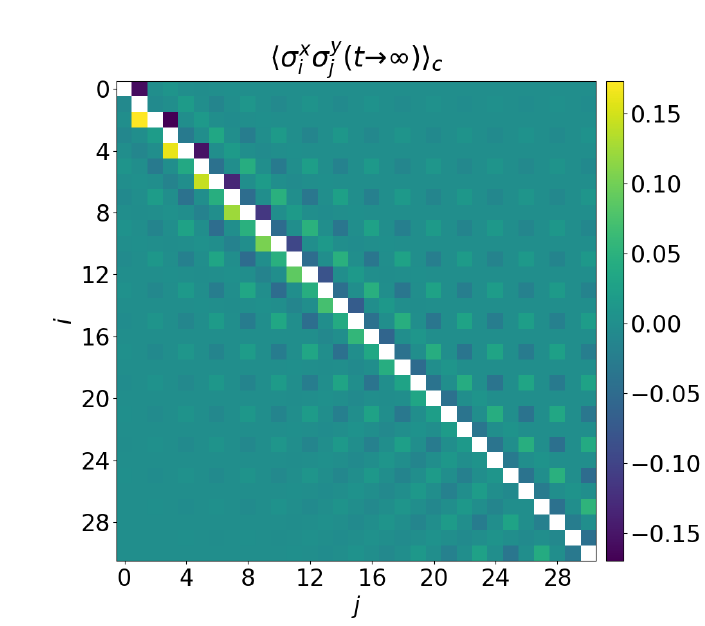
Figure 21: The matrix of X Y connected correlation function of all qubit pairs at the final time, similar to Fig. 20, but for the simulation with g correlations are smaller in magnitude as compared with Fig. 20, while their spatial decay length is noticeably